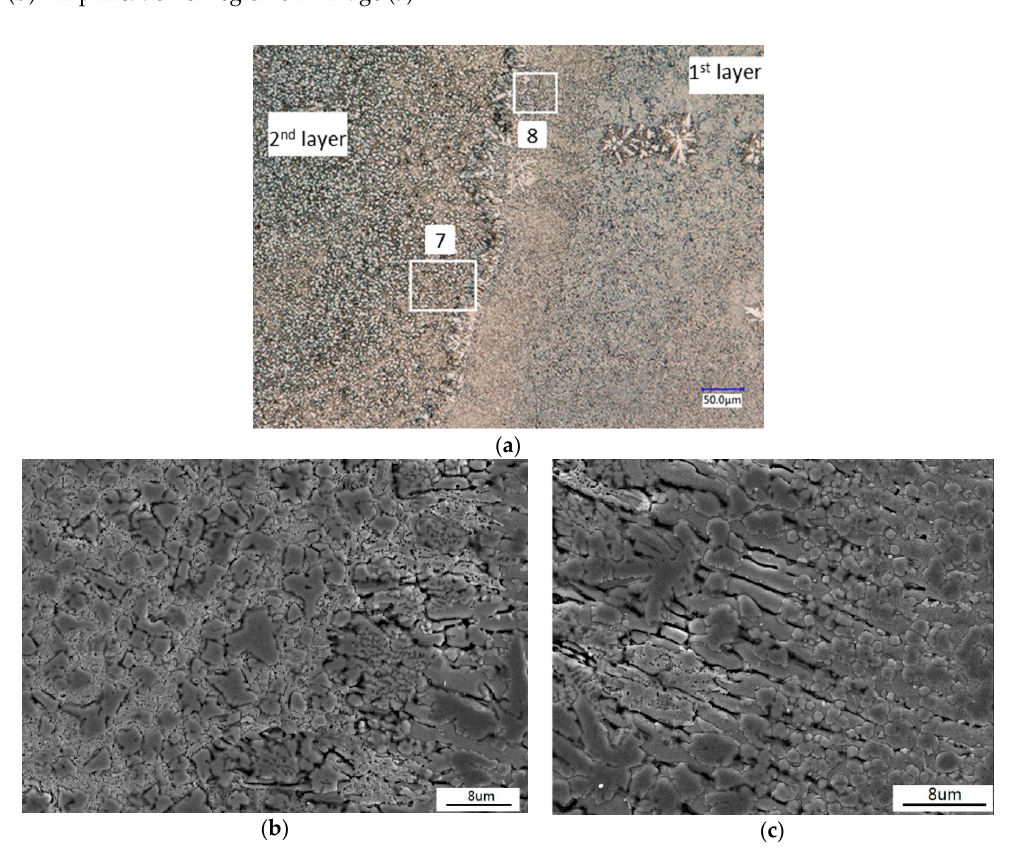
Figure 8. Cross-sectional OM image and SEM image of the overlap region of Coating 1: ( a ) Amplification of region 7 in image ( a ); ( b ) Amplification of region 6 in image ( a ); ( c ) Amplification of region 8 in image ( a ).